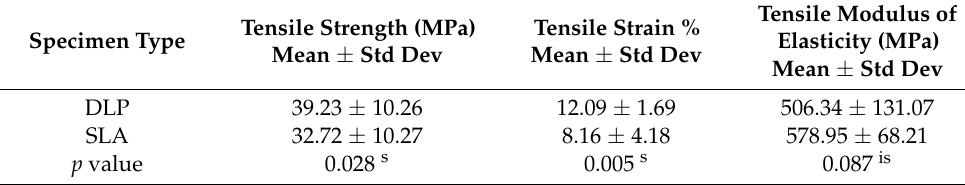
Table 4. Tensile strength (tensile stress at maximum load), tensile strain at maximum load, and tensile modulus of elasticity values of the DLP and SLA printed